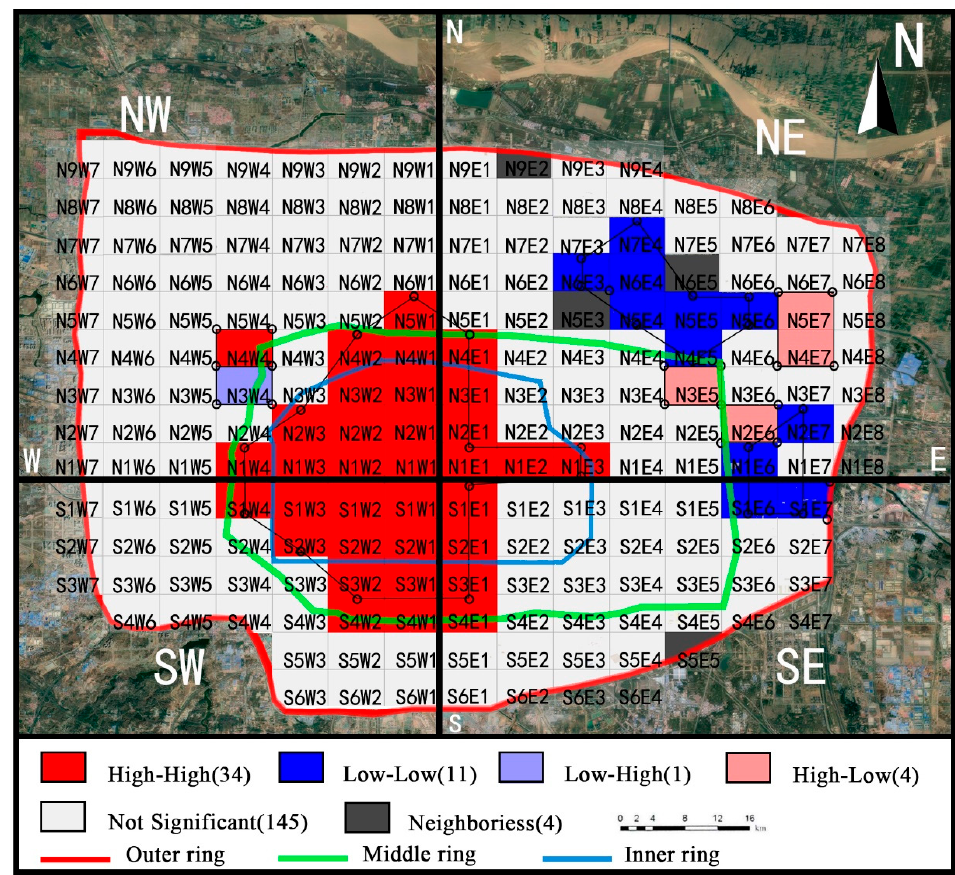
Figure 9. Local auto-correlation in multi-dimensional bivariate space.